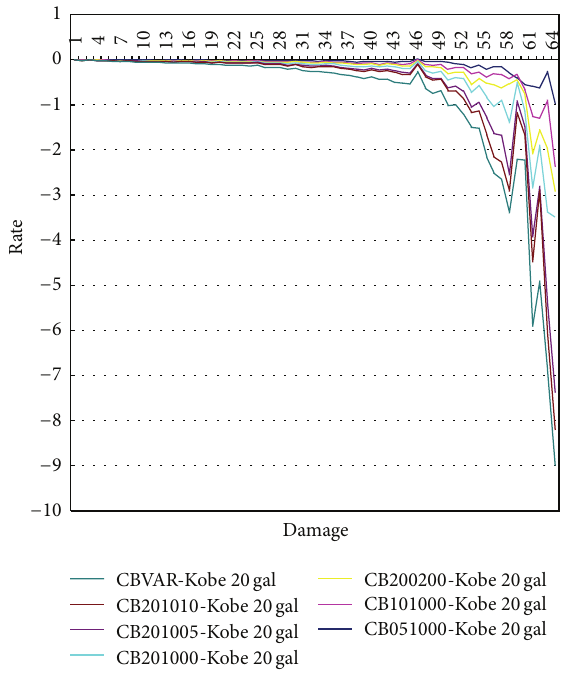
Figure 12: The analysis results of IDMS for various test specimens. Table 1: The identification number of specimen number. Specimen No. 𝐵 mm 𝐿 cm 𝑌